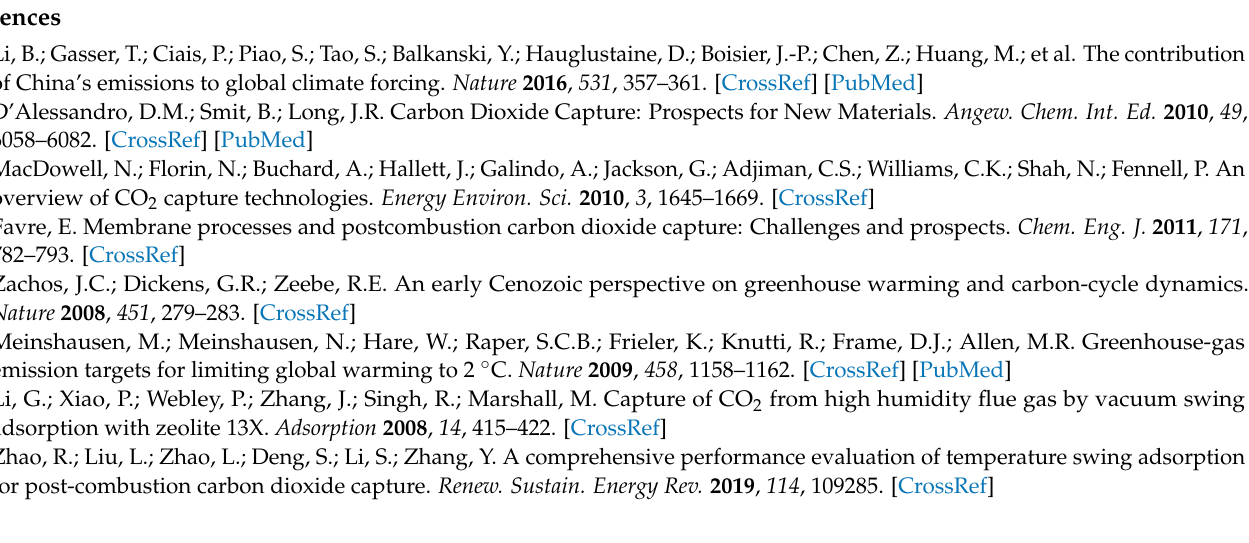
and 4). Figure S7: (a) Freundlich and (b) Langmuir fitted adsorption isotherms of M/P-0.1-600-2 at different temperatures. Table S1: N content of M/P-0.1-T-2 (T = 0, 300, 400, 500, 600, and 700) based on XPS results. Table S2: BET data and CO 2 adsorption capacity of all samples. Table